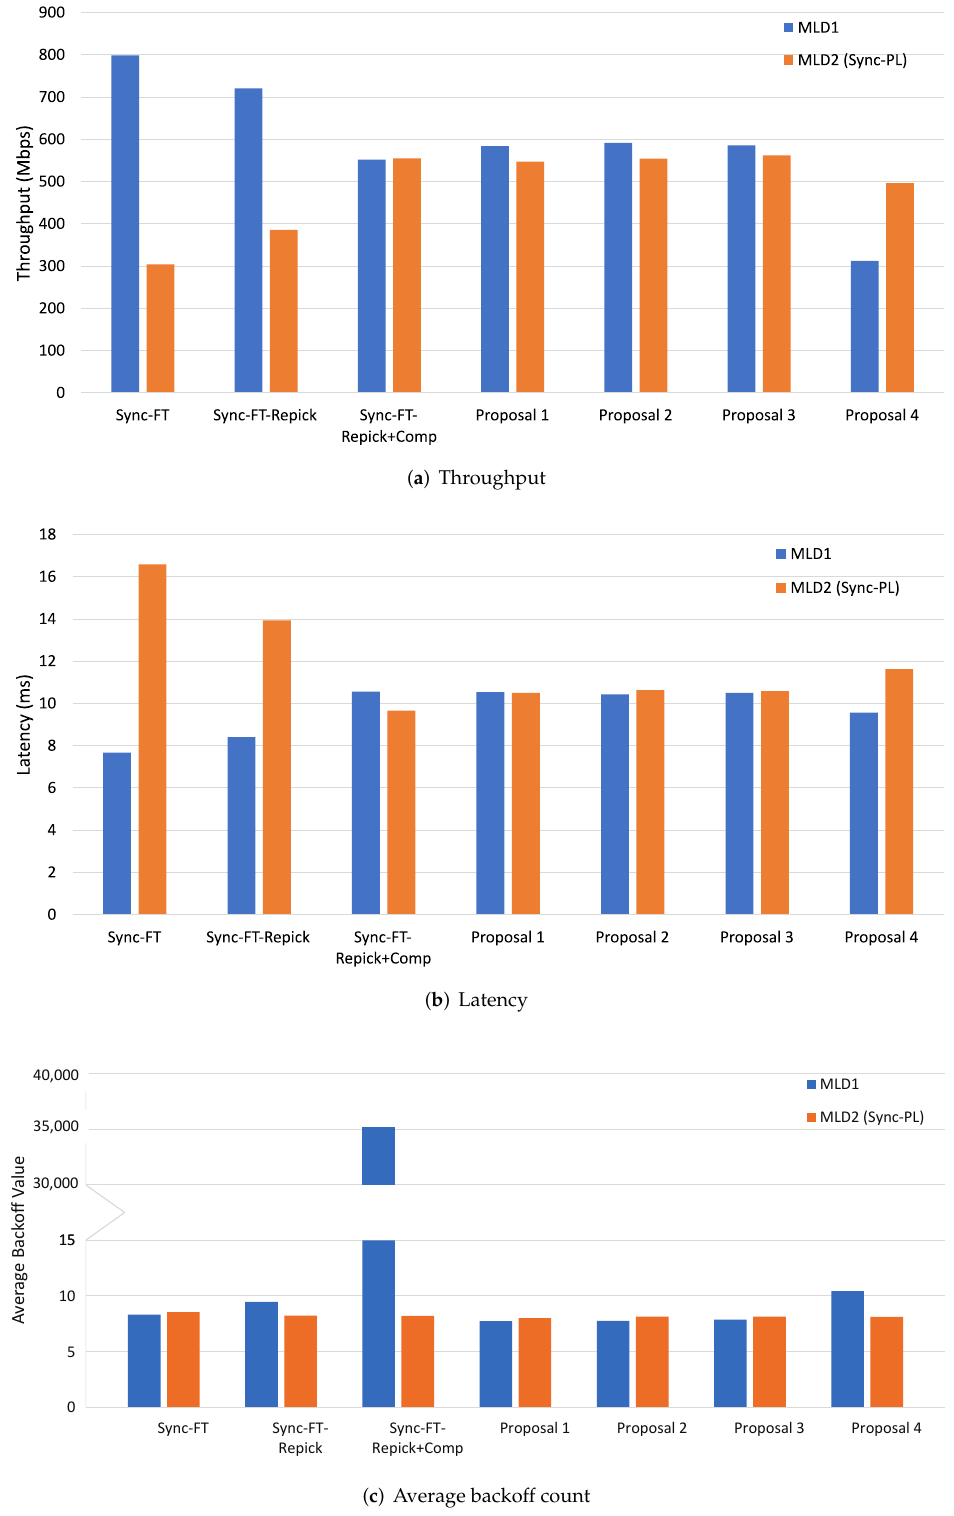
Figure 8. MLD vs. MLD performance in the single-spot deployment scenario.